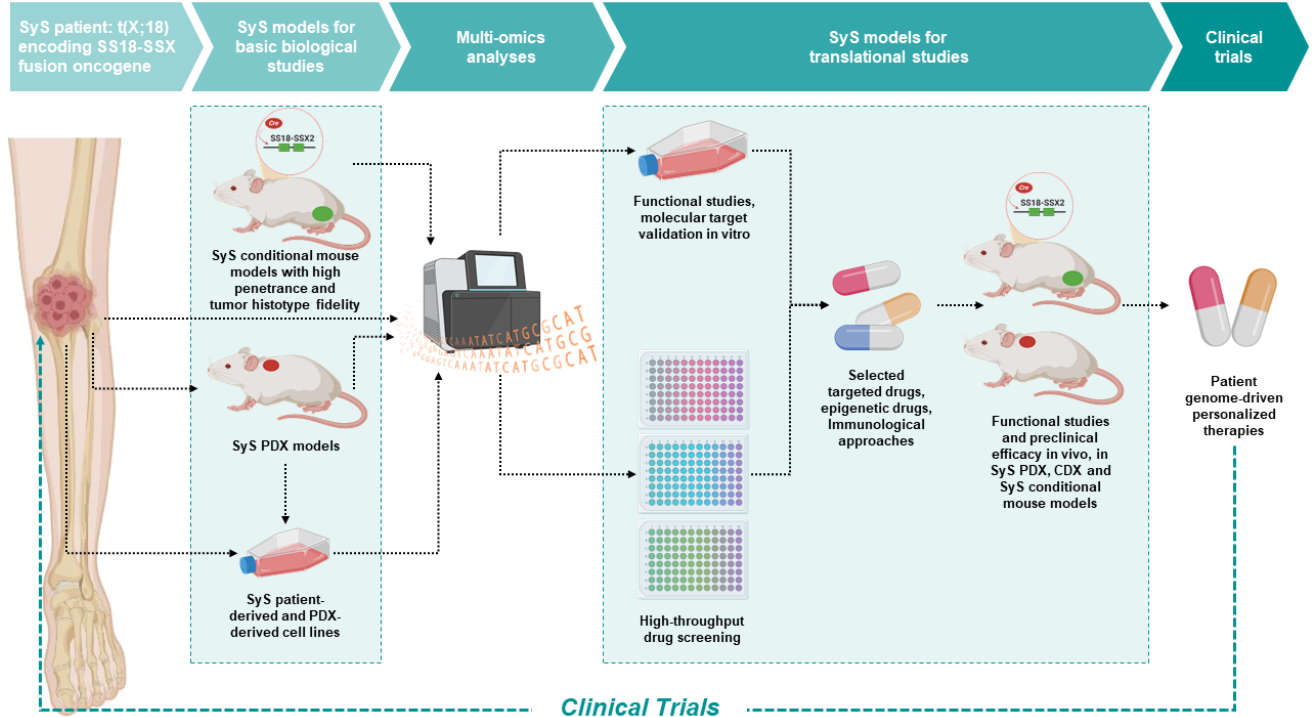
Figure 1. Modeling SyS for the development of targeted, genome-driven, therapeutic approaches. The research on SyS, proceeding from biological and molecular investigations to translational studies, can take advantage of: (I) conditional mouse models, based on Cre technology, carrying a floxed SS18-SSX fusion gene and developing SyS closely resembling human SyS; (II) SyS PDX models; (III) SyS cell lines for in vitro and in vivo studies (cell-derived xenograft, CDX). Molecular and genetic analyses followed by in vitro functional and molecular target validation and high-throughput drug screening can lead to the selection of the most promising drugs to be evaluated for preclinical efficacy in vivo in multiple PDX models (PDX preclinical trials) in immunodeficient mice and/or in SyS conditional mouse models in immunocompetent mice. The final aim is the design of new personalized genome-driven therapeutic options for SyS patients (created with Biorender.com).